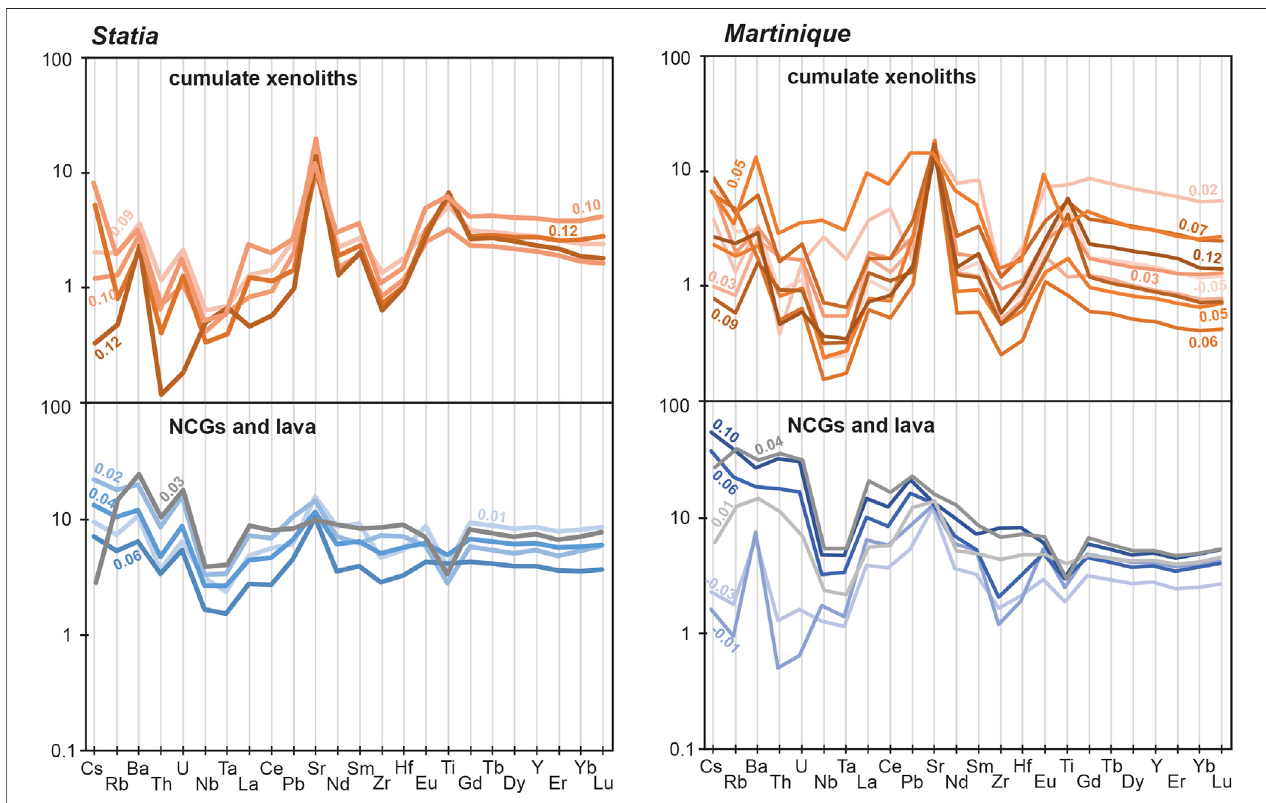
FIGURE 2 | Multi-element normalised diagrams of Statia and Martinique whole-rock analyses divided into cumulates (orange lines) and NCG ’ s (blue lines) and Lavas (grey lines). Measured δ 56 Fe values of samples are labelled on each line.